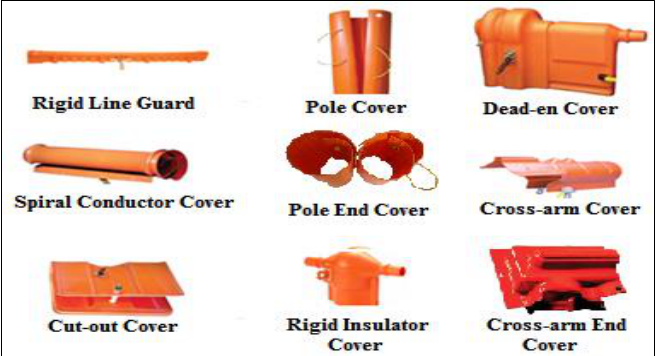
Figure 1: Rigid insulation covers most used in Cuba. Source: [4-5].